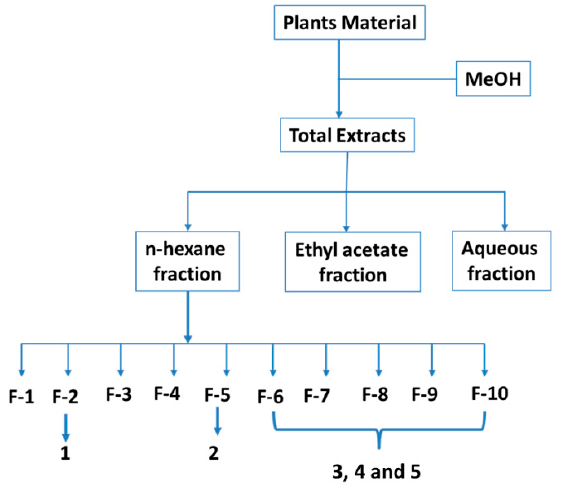
Figure 8. Method of obtaining extracts, fractions, and compounds.